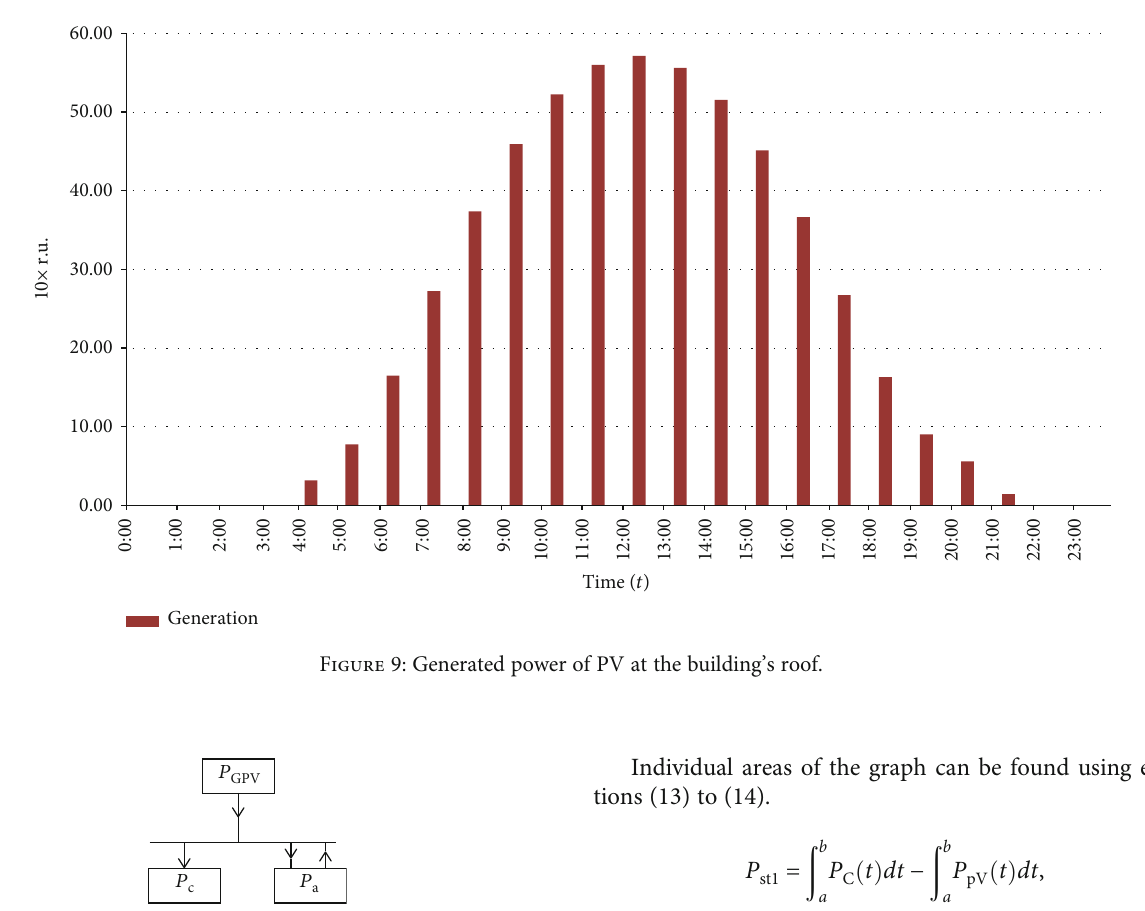
Figure 10: Power